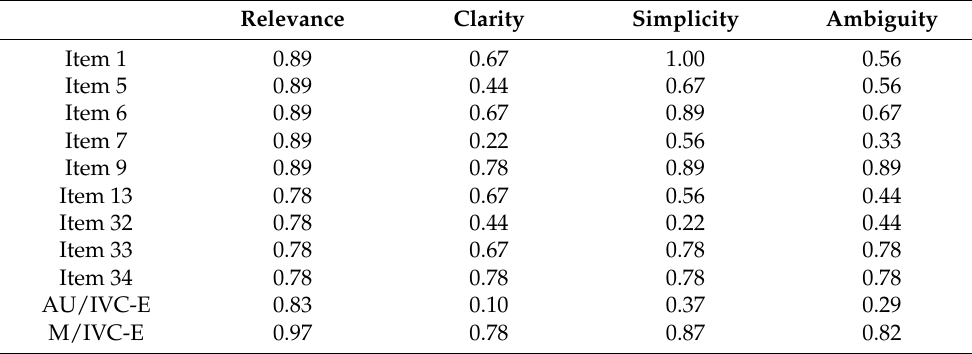
Table 1. Content Validity Indexes (CVI) of NPmot.pt (items and scale).